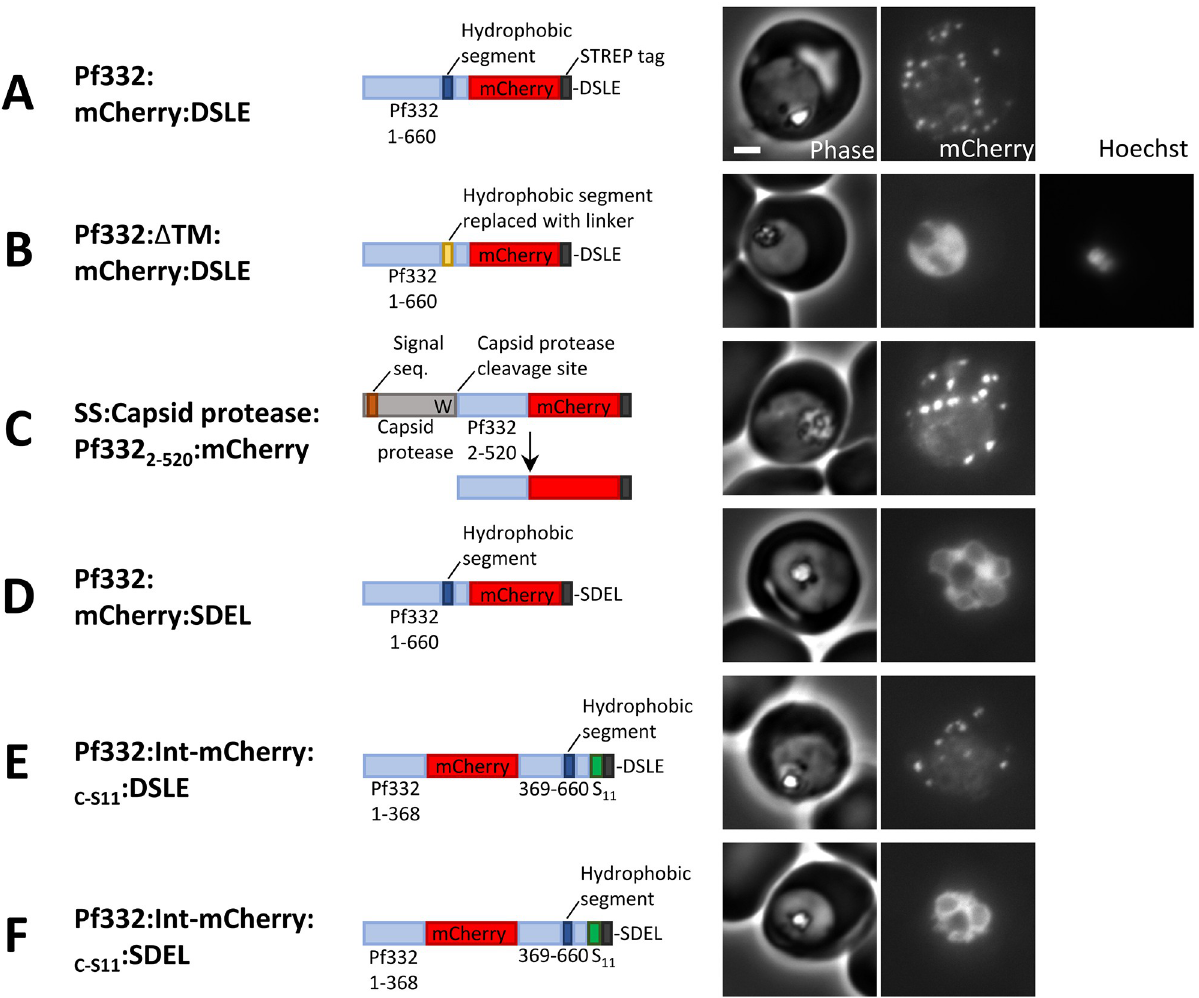
Fig 1. Export of a Pf332 model protein into the infected red blood cell. (A-F) Phase contrast and fluorescence images of parasites expressing the indicated proteins. Scale bar: 2 μ m.